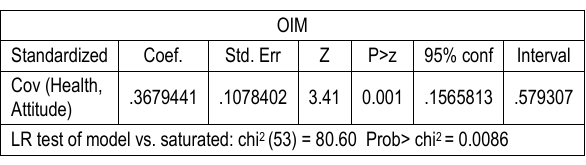
Table 2. Covariance between health consciousness